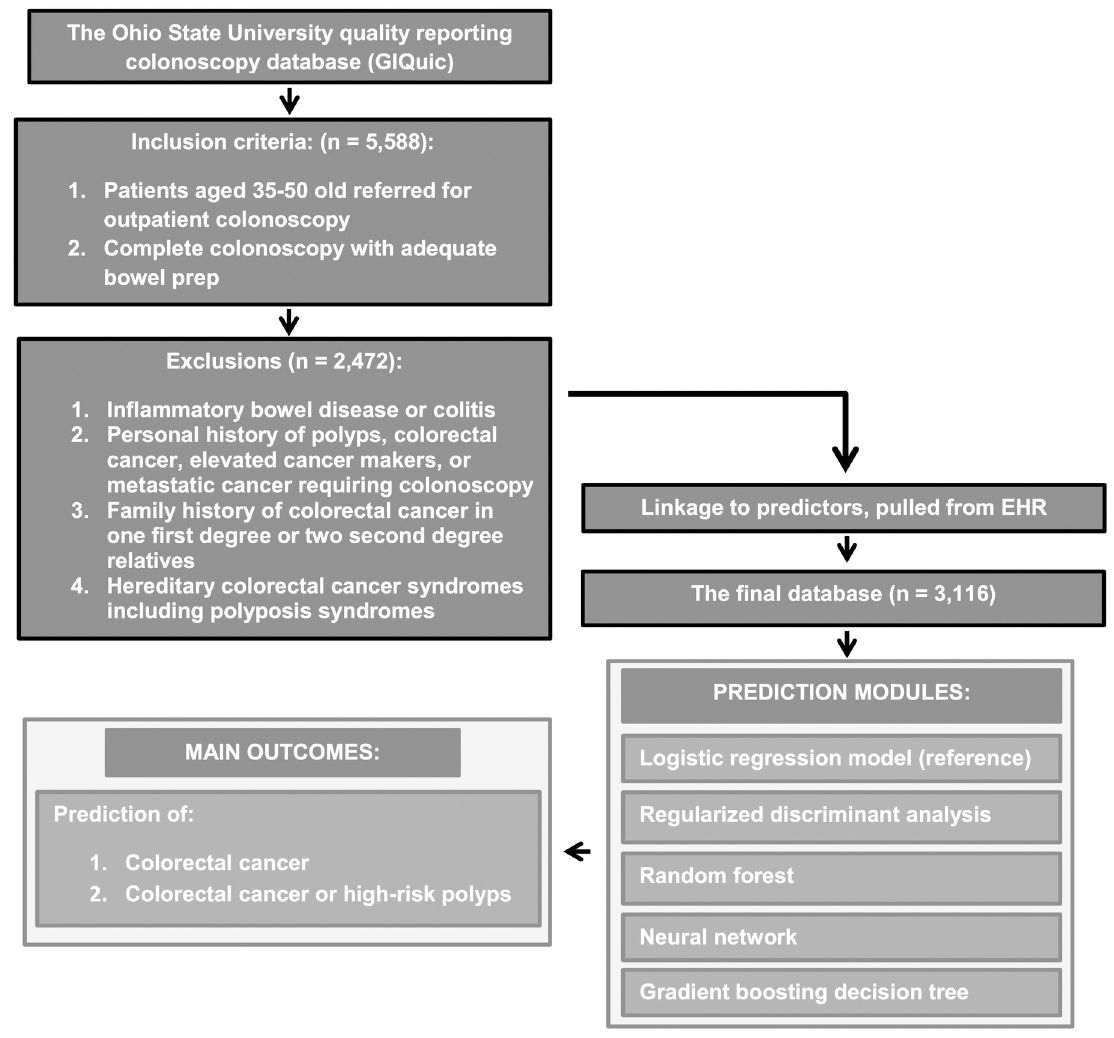
Fig 1. Study plot detailing study flow as well as inclusion and exclusion